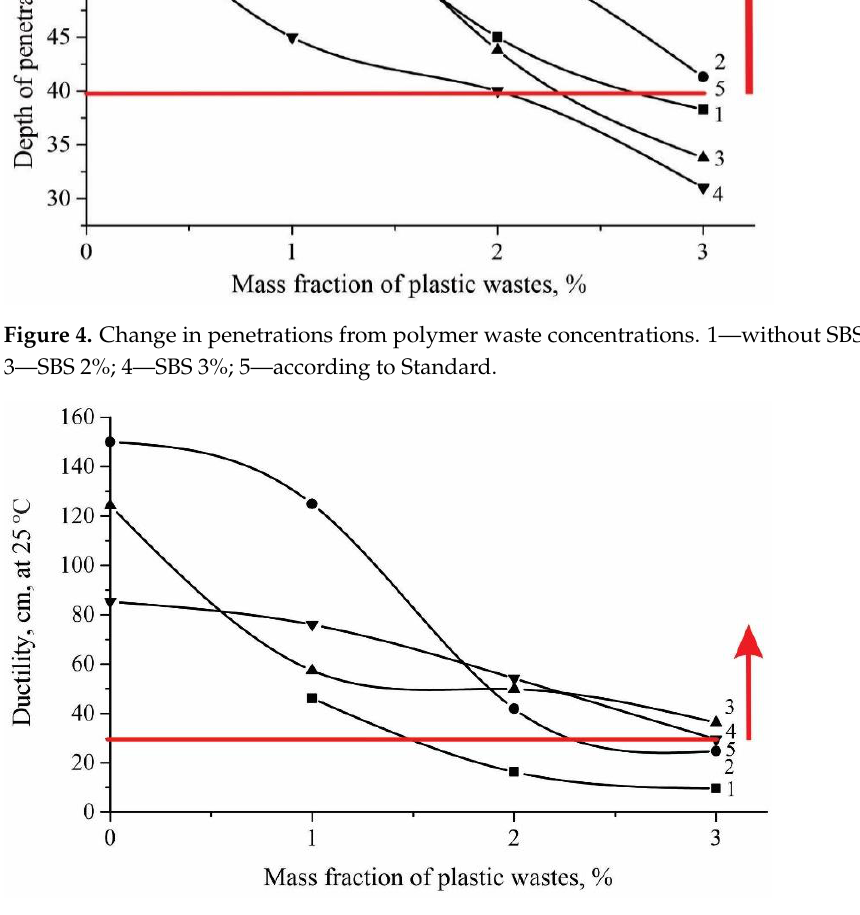
Figure 6. Change in brittleness temperature on Fraas from polymer waste concentrations. 1 — with- out SBS; 2 — SBS 1%; 3 — SBS 2%; 4 — SBS 3%; 5 — according to Standard.